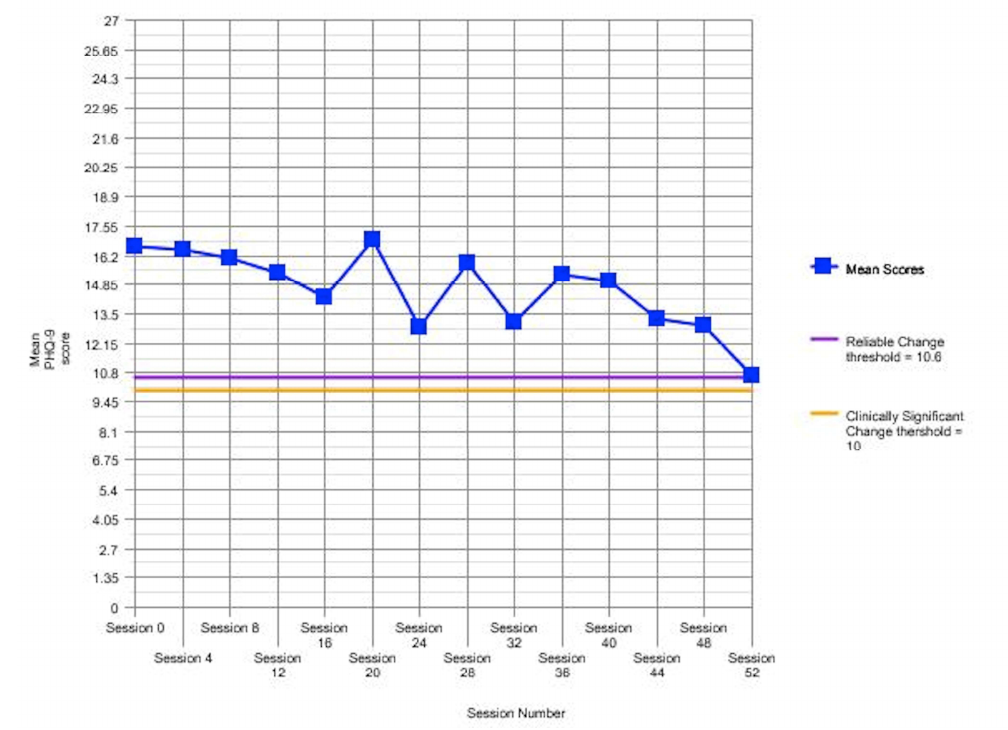
Figure 2: Table 5: Mean PHQ-9 score: 8 long-term